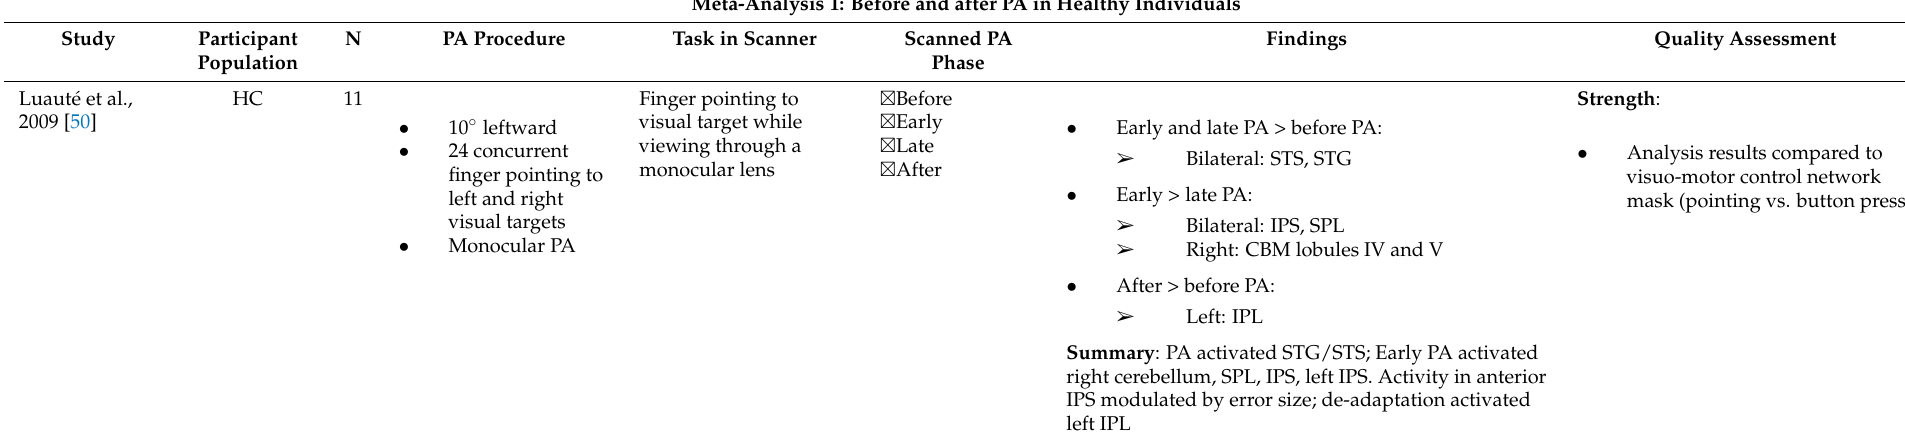
Meta-Analysis 1: Before and after PA in Healthy